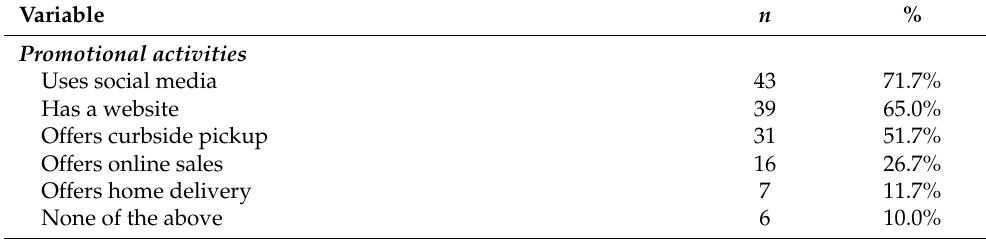
Table 1. Promotional activities and product offerings in a sample of vape and vape-and-smoke shop owners or managers, n =